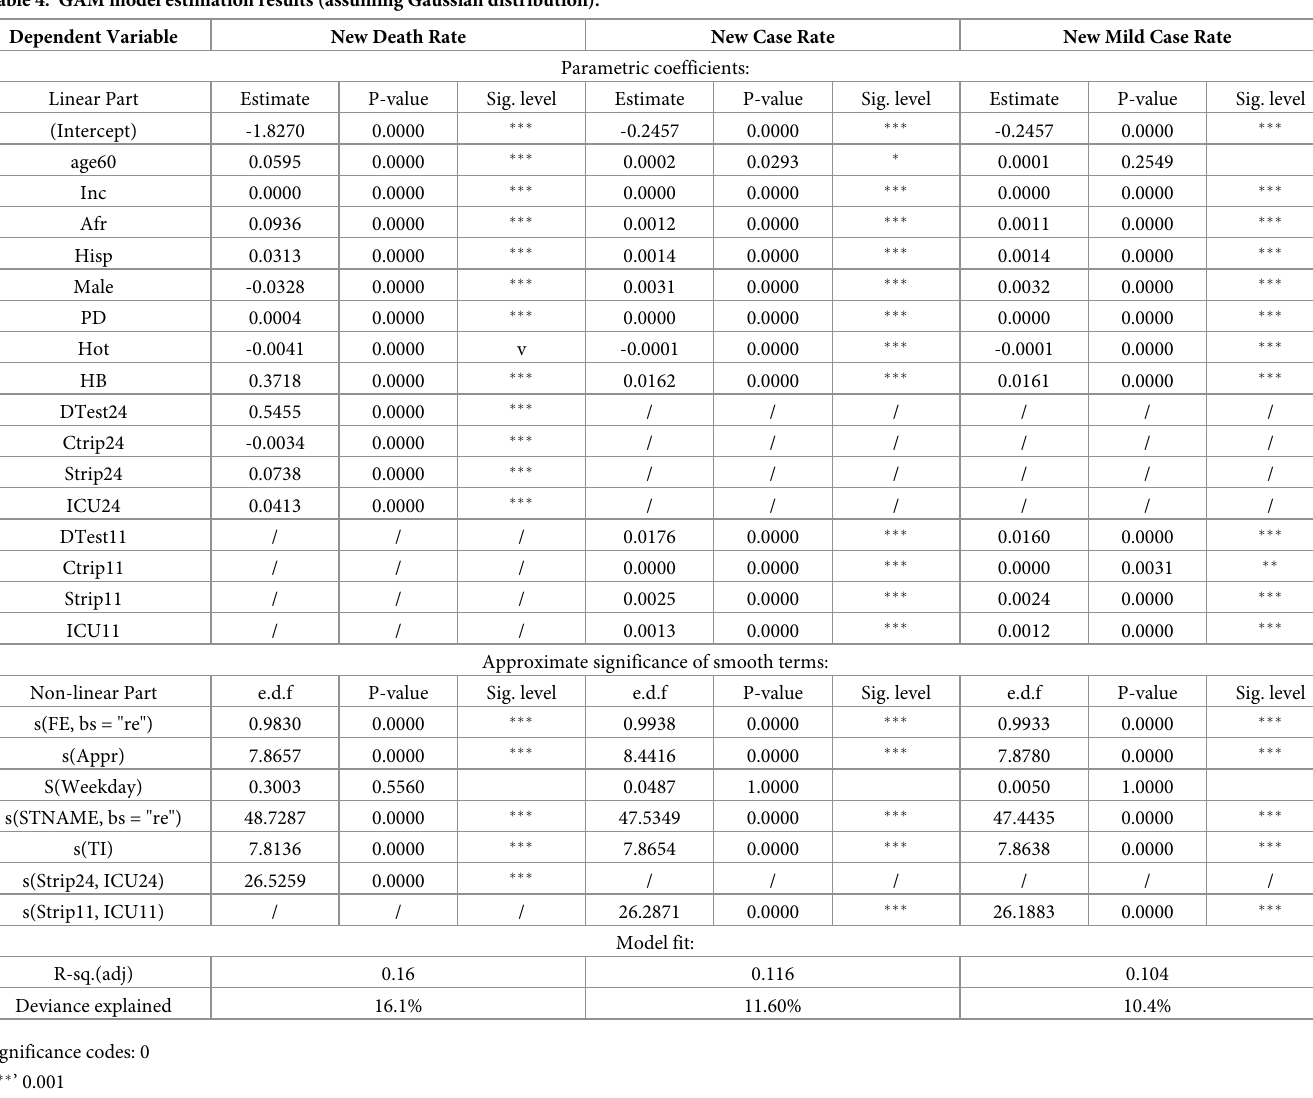
Table 4. GAM model estimation results (assuming Gaussian distribution).